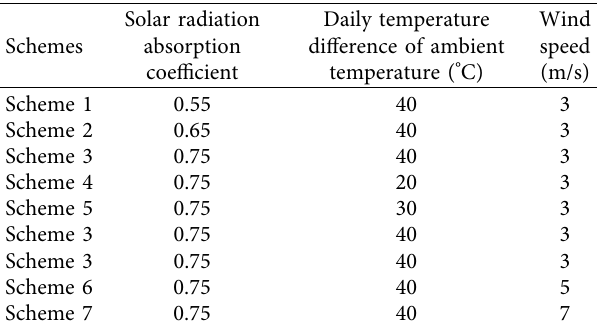
Figure 14: The distribution of temperature field (4 am): (a) A1-A2, (b) B1-B2, (c) C1-C2, and (d) D1-D2. Table 2: The design schemes for sensitivity